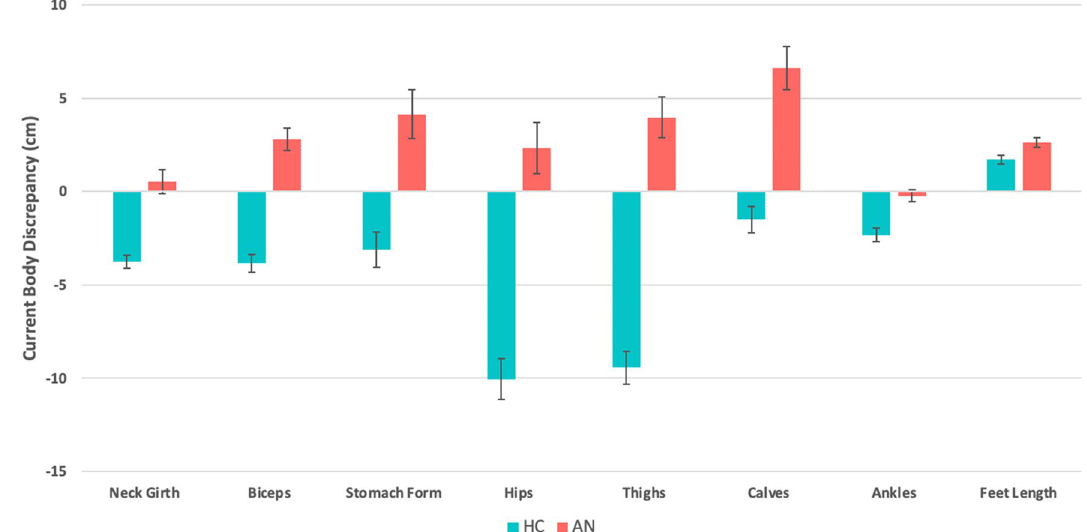
Figure 2. Summary of current body discrepancy score differences between AN and HC. Of the total set of 23 body part measurements only those showing significant differences are displayed (P < 0.05, corrected for multiple comparisons using the Benjamini–Hochberg procedure). Positive values indicate overestimation of true body part size, negative values indicate underestimation, and zero indicates correct estimation. Standard errors are represented by error bars.